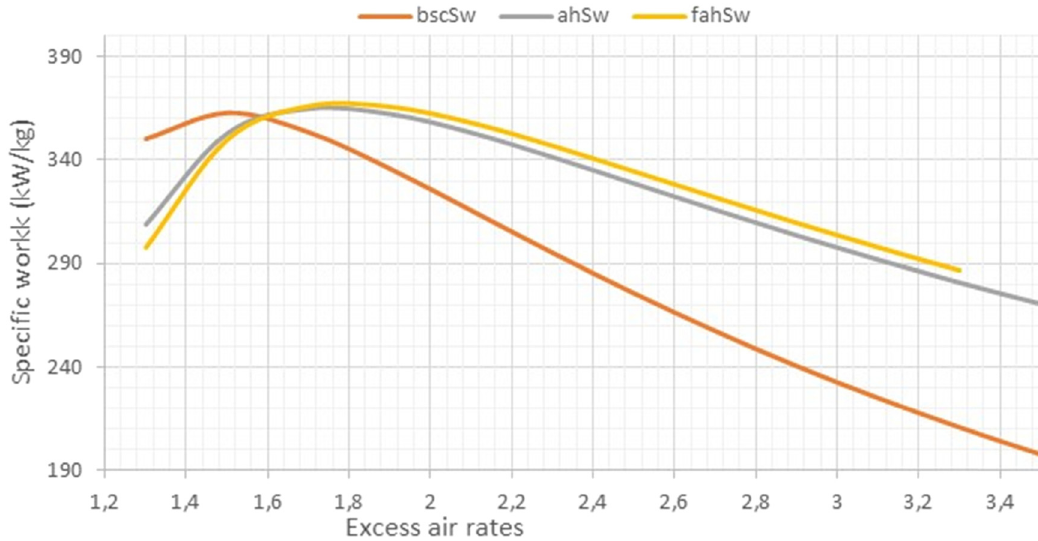
Figure 12: Variation of the speci fi c work with excess air rates for bsc, ah and fah cogeneration